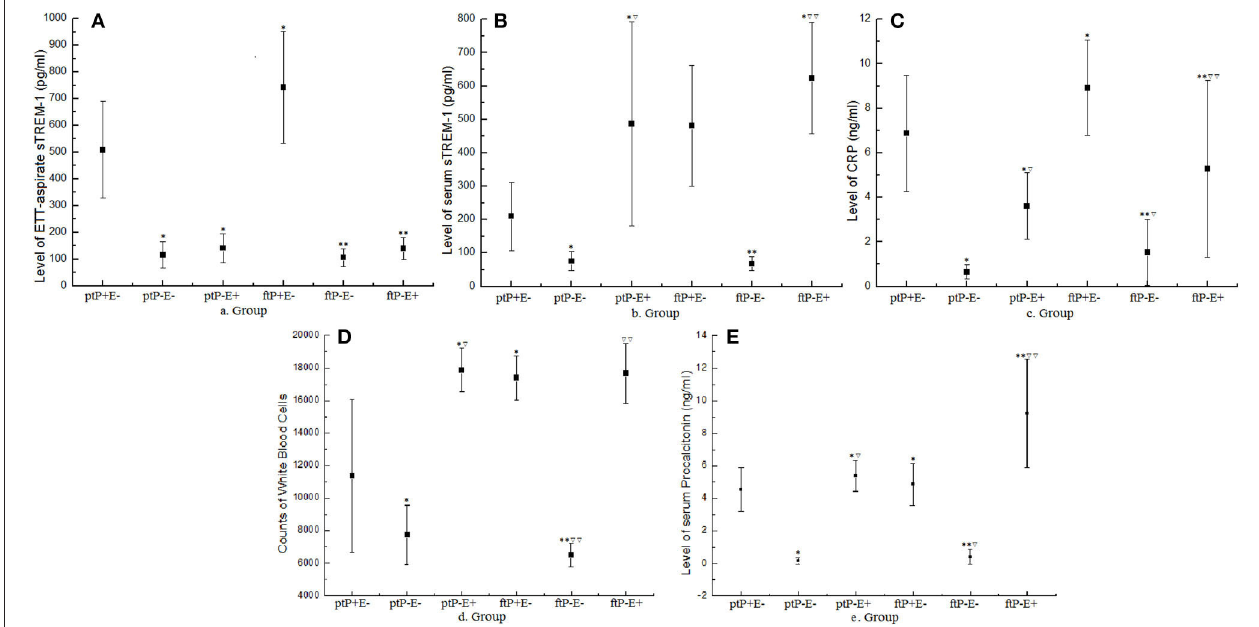
FIGURE 2 | Values of indicators on the fourth day on the mechanical ventilator. Dots represent mean values and error bars represent the standard deviation. Groups are based on three categories: preterm (pt) or full-term (ft); NVAP (P + ) or non-NVAP (P–); and extrapulmonary infection present (E + ) or absent (E–). ETT, endotracheal tube; sTREM-1, soluble triggering receptor expressed on myeloid cells-1; CRP, C-reactive protein; NVAP, neonatal ventilator-associated pneumonia. * P < 0.05 when compared with the ptP + E– group; ▽ P < 0.05 when compared with the ptP–E– group; ** P < 0.05 when compared with the ftP + E– Group; ▽▽ P < 0.05 when compared with the ftP–E–